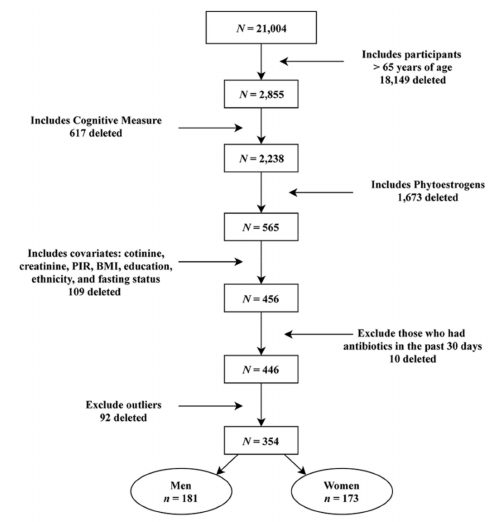
Figure 1. Flowchart based on the inclusion and exclusion criteria to obtain the final